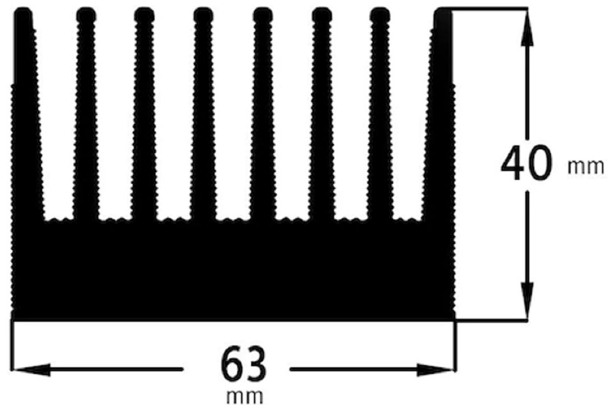
Figure 5. Aluminium heat